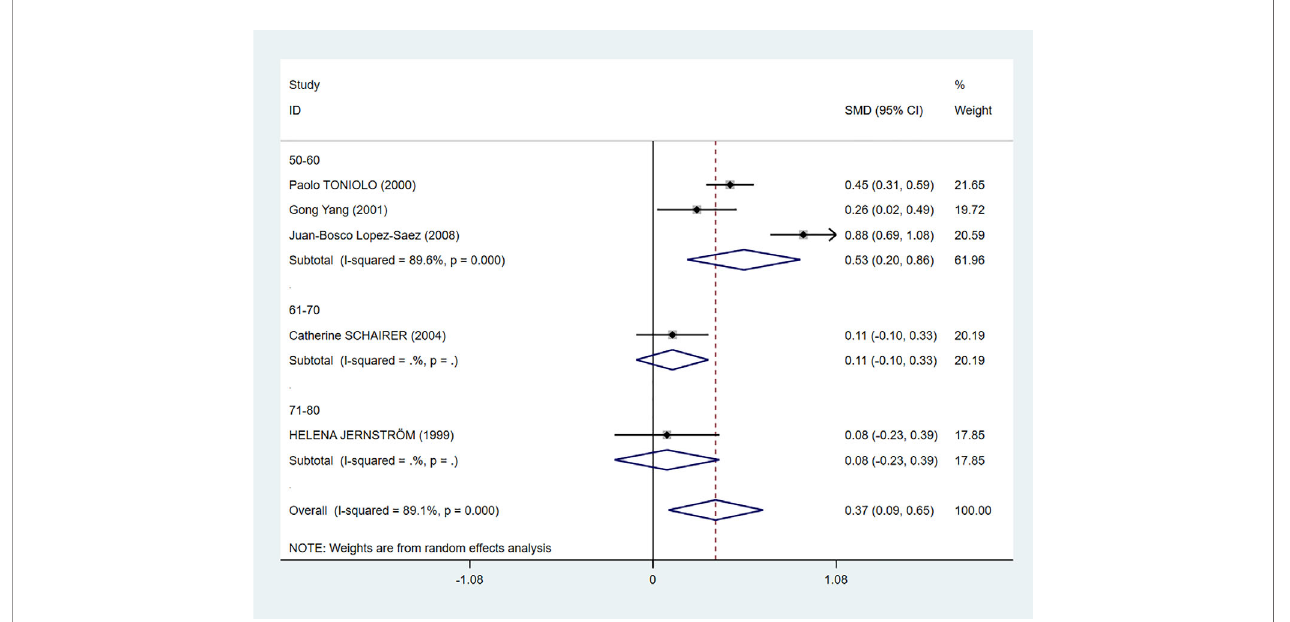
FIGURE 5 | Subgroup analysis of the association between C-peptide and breast cancer in different ages. The size of the square box is proportional to the weight that each study contributes in the meta-analysis. The overall estimate and CI are marked by a diamond. Summary estimates were analyzed using a random-effects model. C-peptide levels are positively associated with breast cancer risk in the age 50 – 60 group.